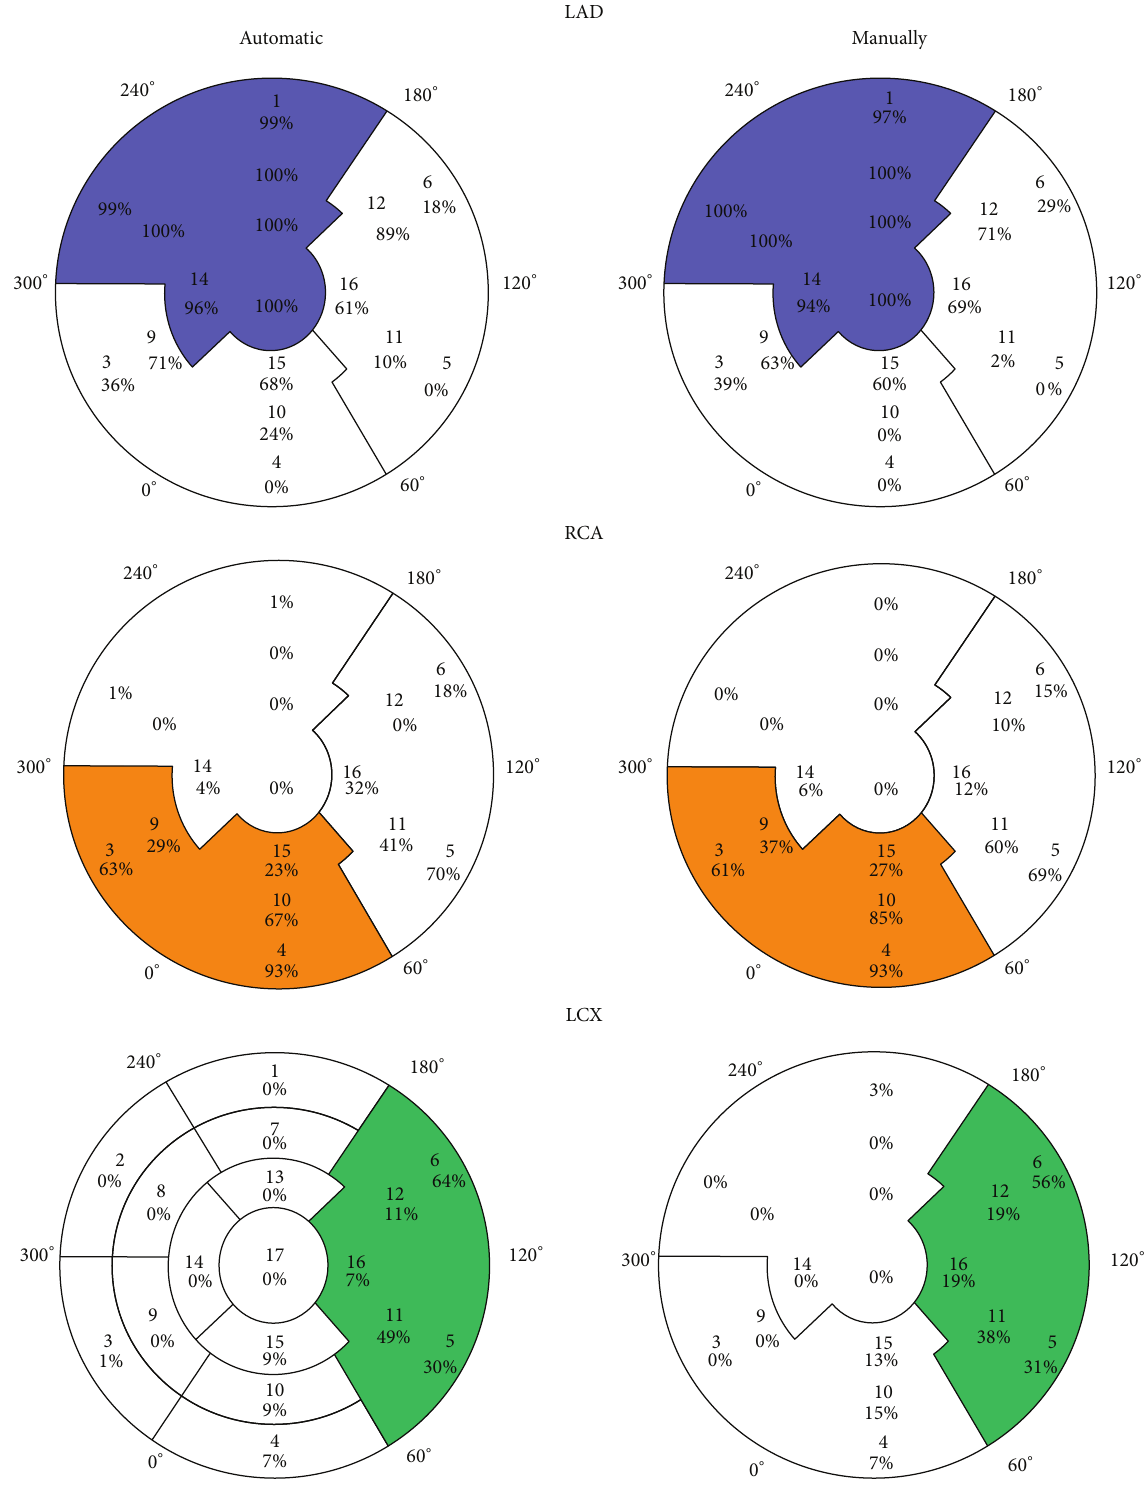
Figure 5: Distribution of LGE-CMR according to the AHA proposal and infarct related artery (IRA) by automatic and manual assessment. The automatic assessment is calculated from all transverse slices from the basal, mid-, and apical regions, whereas the manual assessment is calculated from one representative transverse slice from the basal, mid-, and apical cavities. For all scars, the endocardial extent of infarction ( Δ𝜙 ) is assessed (0 ∘ –360 ∘ ) and the total sum is calculated and allocated to each segment. The percent marking is the percentage of the total sum of Δ𝜙 for each of the 16 segments used in this study; that is, sum of all percentages for one segment is equal to 100%. The manual assessment of segment 17 is also included. The percentage demonstrates the agreement of the observed LGE within each IRA segment as proposed by AHA. The manual assessment of segment 17 is also included in the automatic